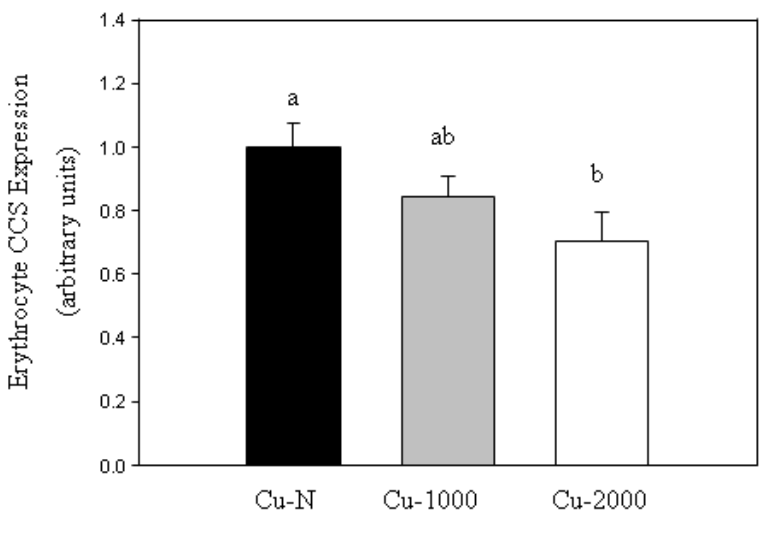
Figure 2. Relative CCS content in erythrocytes of rats fed the Cu-N, Cu-1000 or Cu-2000 diets. The mean of Cu-N rats was arbitrarily set to 1. CCS expression is expressed relative to GAPDH expression. Values are means  SEM. Bars without a common letter differ, P <